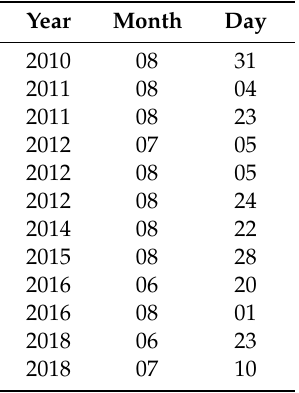
Table 3. Day-0 of Caribbean easterly waves in the composite